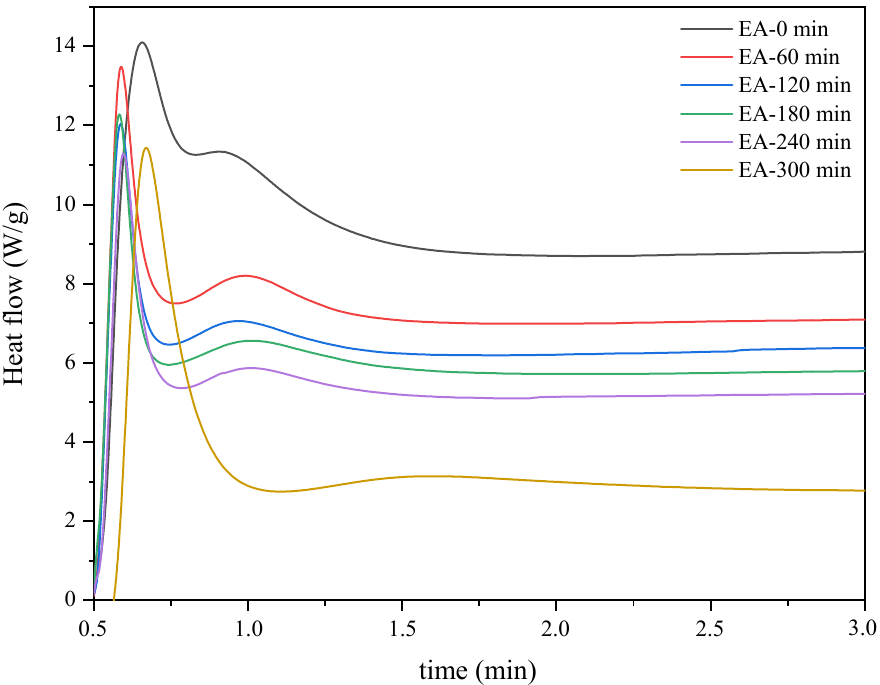
Figure 4. Photo-DSC thermograms corresponding to the photocuring of the reaction mixtures obtained at one-hour intervals (photo-DSC method; mercury UV lamp, 280–480 nm, 100 mW/cm 2 ; composition of the photoreactive formulations: 96 wt% of EA prepolymer, 4 wt% of cationic PI) .